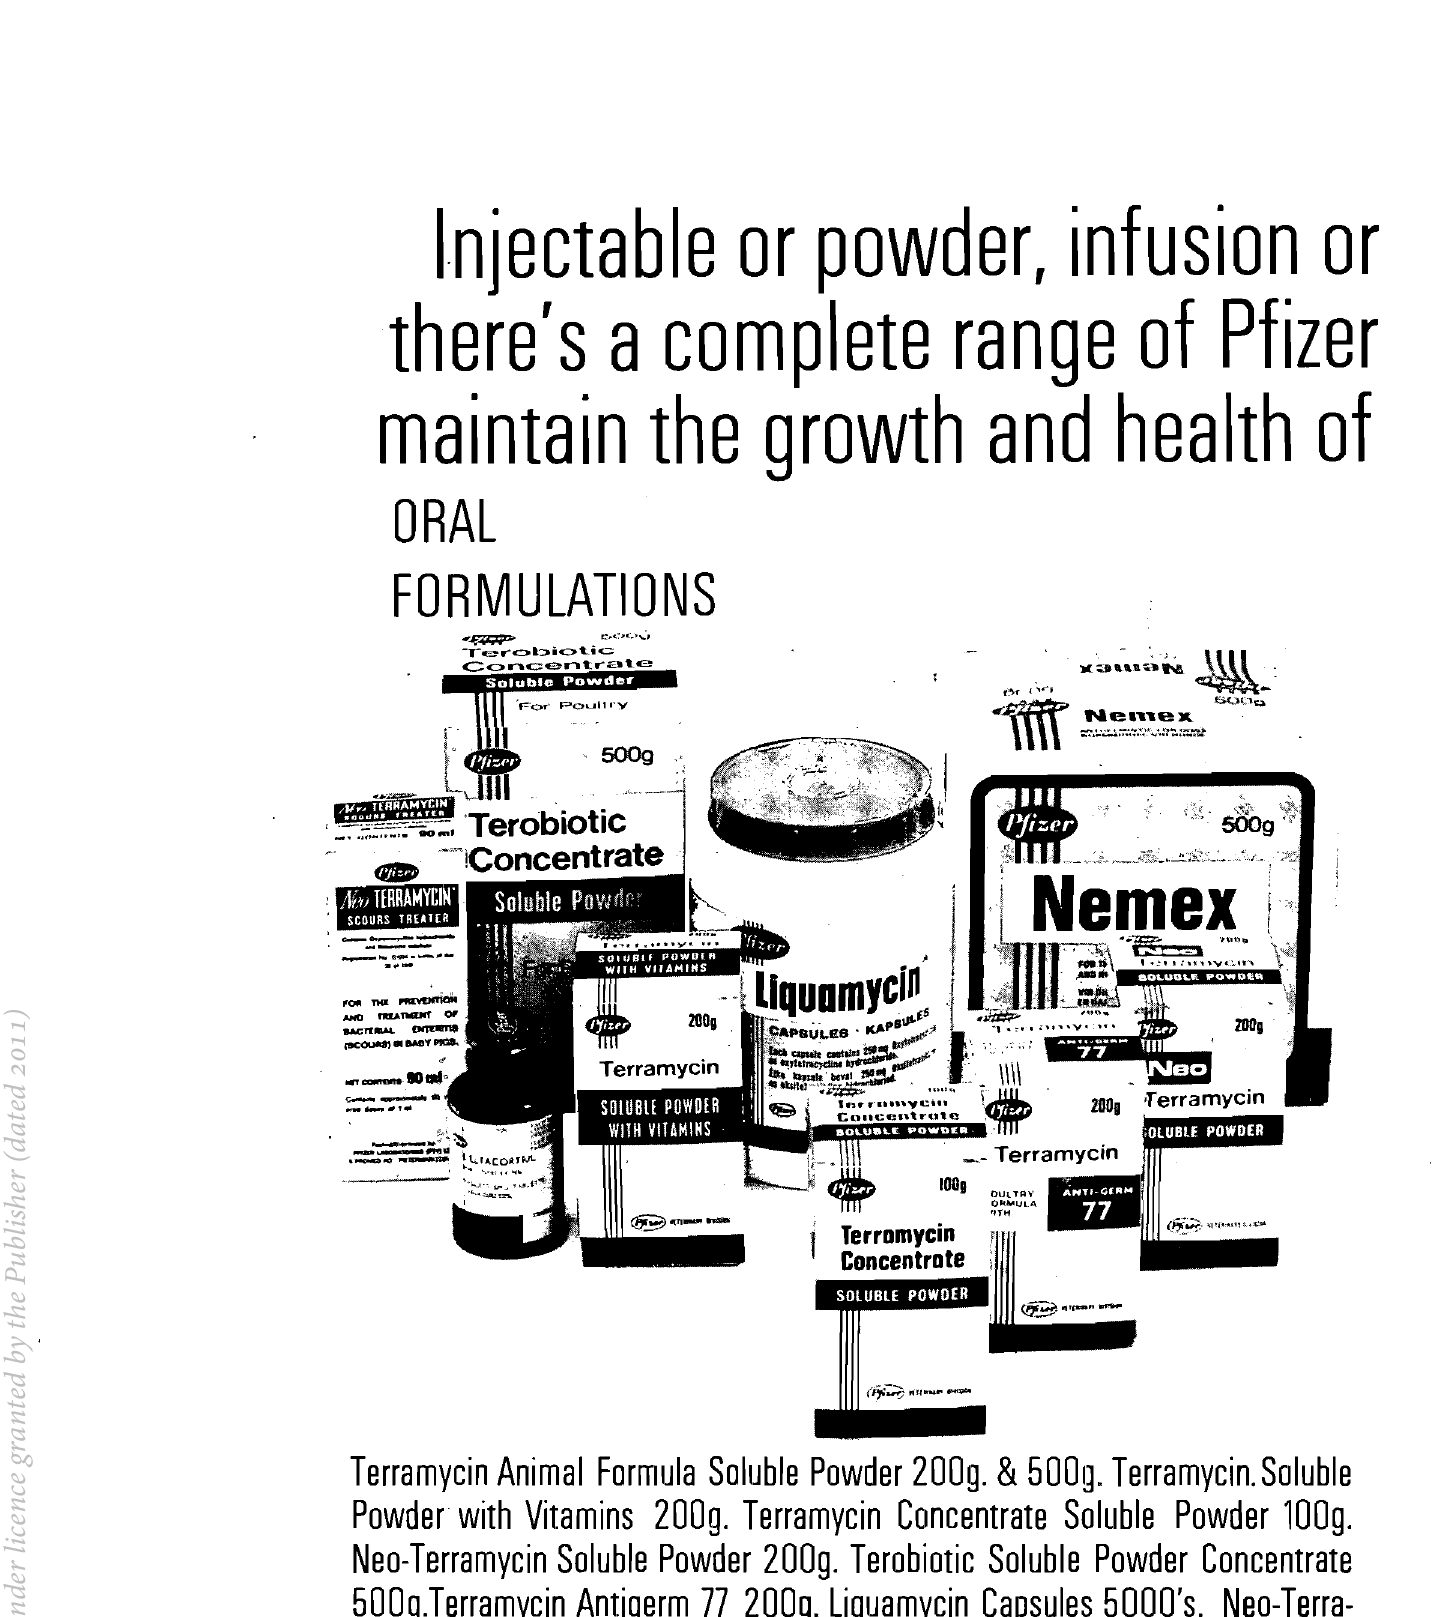
Terramycin Animal Formula Soluble Powder 200g. & 500g. Terramycin.Soluble Powder with Vitamins 200g. Terramycin Concentrate Soluble Powder